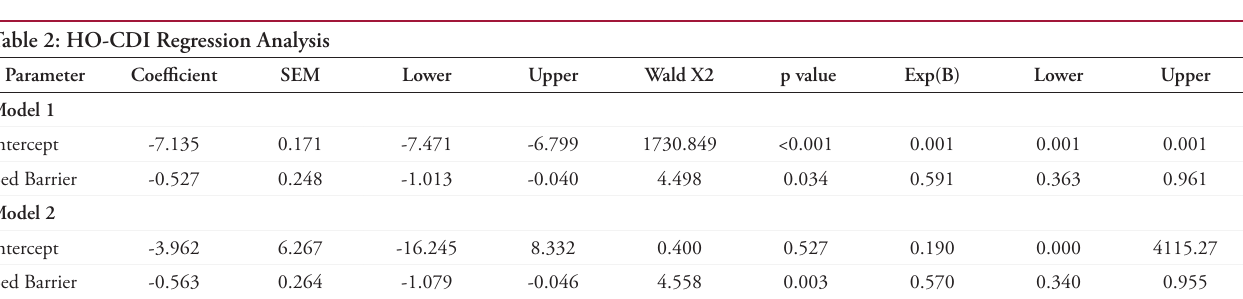
Table 2: HO-CDI Regression Analysis